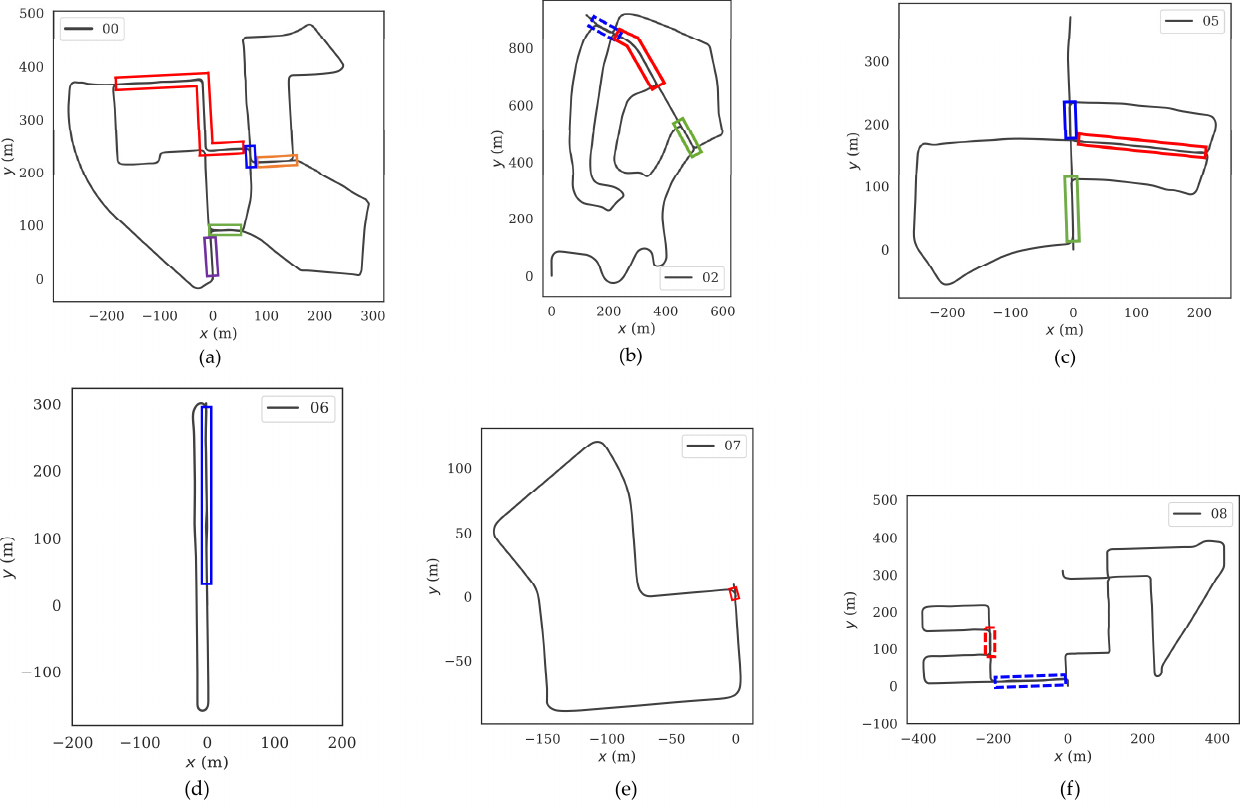
Figure 5. Illustrations of loop closure ground truth for each sequence in KITTI dataset: ( a ) KITTI-00; ( b ) KITTI-02; ( c ) KITTI-05; ( d ) KITTI-06; ( e ) KITTI-07; ( f ) KITTI-08. Different colors indicate different loop closure regions. Solid box and dotted box indicate obverse loop closure and reverse loop closure, respectively.